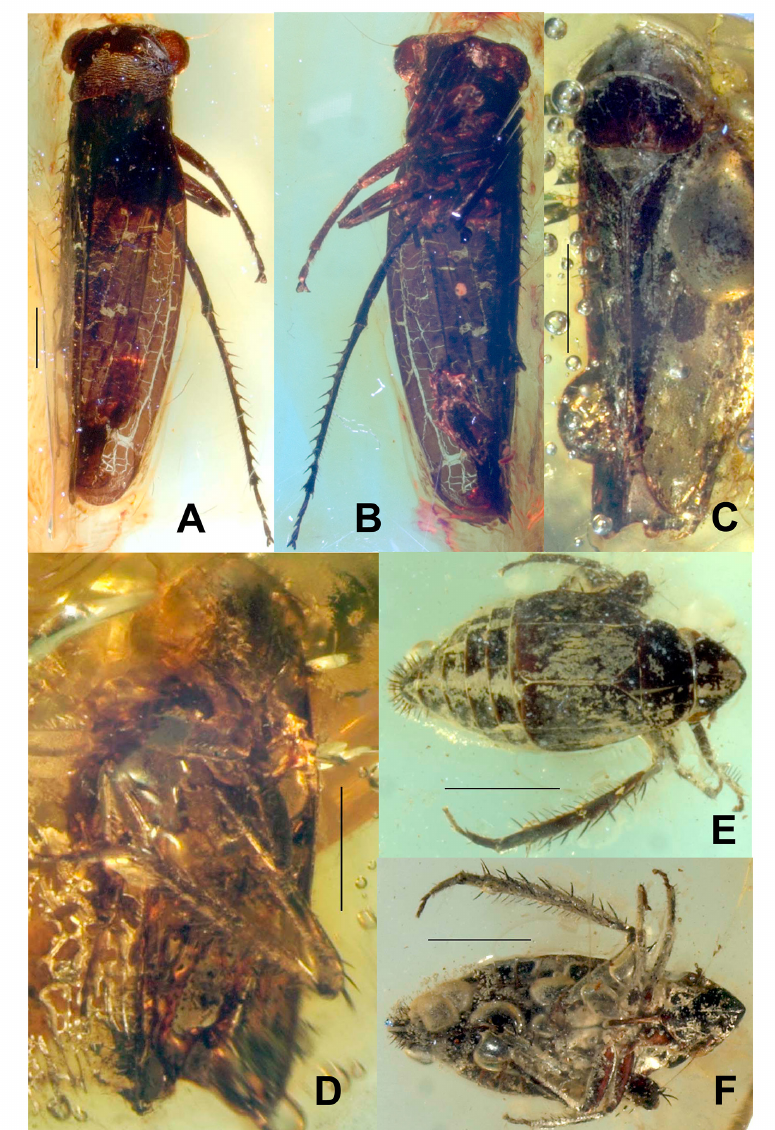
Fig. 1. Habitus in dorsal and ventral view. A-B . Eomegopthalmus lithuaniensis sp. nov. ♀. C-D . Xestocephalites balticus sp. nov. ♂. E-F . Brevaphrodella nigra sp. nov. ♂. Scale bars = 1